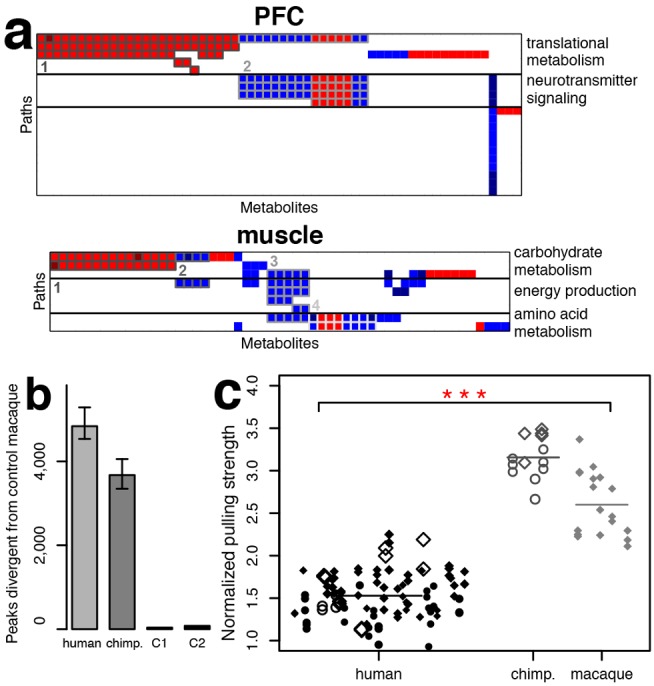
Functions of the human-specific metabolites, environmental effects, and muscle strength experiments.(a) Functional units of KEGG pathways containing significant excesses of metabolites with human-specific concentration profiles in PFC and skeletal muscle. Columns represent metabolites showing human-specific concentration profiles in these tissues. Rows represent KEGG pathways enriched in the respective metabolites. Colors show higher (red) and lower (blue) concentration levels in humans compared with the other two primate species. Only pathways supported by human-specific expression of enzymes are shown. Metabolites directly linked to the enzymes with a human-specific expression profile in these tissues are indicated by darker shades of red and blue. Numbers and borderlines of different shades of gray indicate metabolite groups showing correlated concentration profiles across multiple pathways. Plotted metabolites, pathways, and metabolite groups are listed in Tables S14, S15 and further illustrated in Figures S10, S11. (b) Numbers of metabolite peaks differentiating humans, chimpanzees, and macaques subjected to environmental condition 1 (C1: physical activity deprivation), and macaques subjected to environmental condition 2 (C2: high nutrition and physical activity deprivation) from the control macaques in any of the five tissues (t-test, p<0.01). Numbers of peaks showing significant concentration differences between control macaques and humans or chimpanzees were estimated using six randomly chosen human or chimpanzee individuals. The error bars show 0.05 and 0.95 quintiles of the significant peak number distributions calculated by randomly sampling six human or six chimpanzee individuals 1,000 times. (c) Pulling strength of humans, chimpanzees, and macaques normalized by individual body weight. The shape of the symbols represents the individual's sex: circles: females, diamonds: males. Empty symbols represent trials measured using the apparatus built in the Leipzig primate center, filled symbols those measured using the apparatus built in Shanghai. The size of the symbols is proportional to the individual's age normalized by the maximal life expectancy of the species: humans: 120 years, chimpanzees: 60 years, macaques: 40 years. Up to three of the best results per individual are shown. Asterisks indicate the significance of muscle strength difference between humans and the other two species (Wilcoxon test, p<0.001). The highest measurement of each individual was used in the p-value calculation.